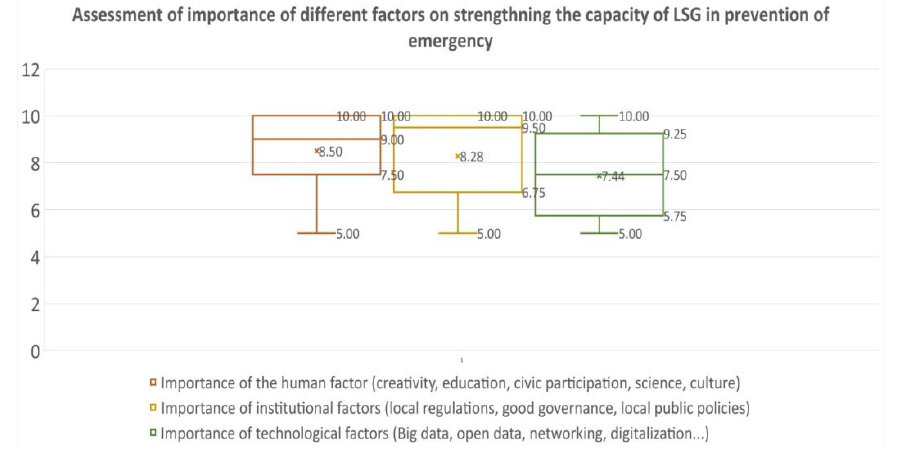
Figure 4: Assessment of Importance of Different Factors on Strengthening the Capacity of LSG In Prevention of Emergencies (Source: Authors’